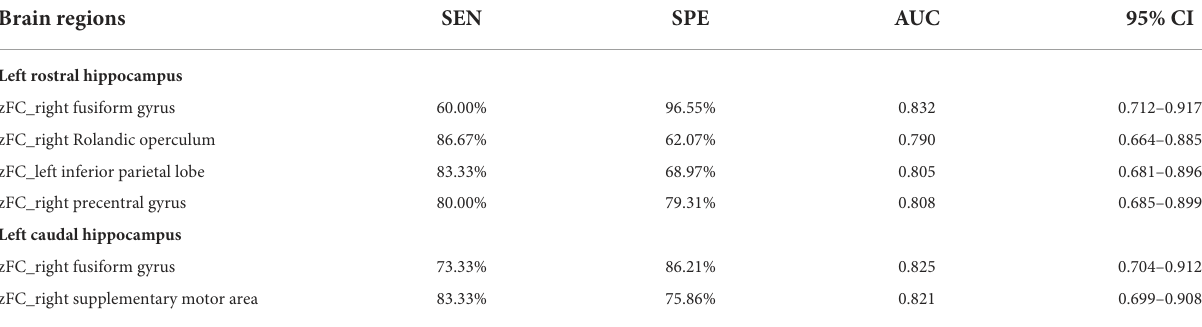
TABLE 3 The ROC analysis for altered brain regions that distinguish PNE children from HC